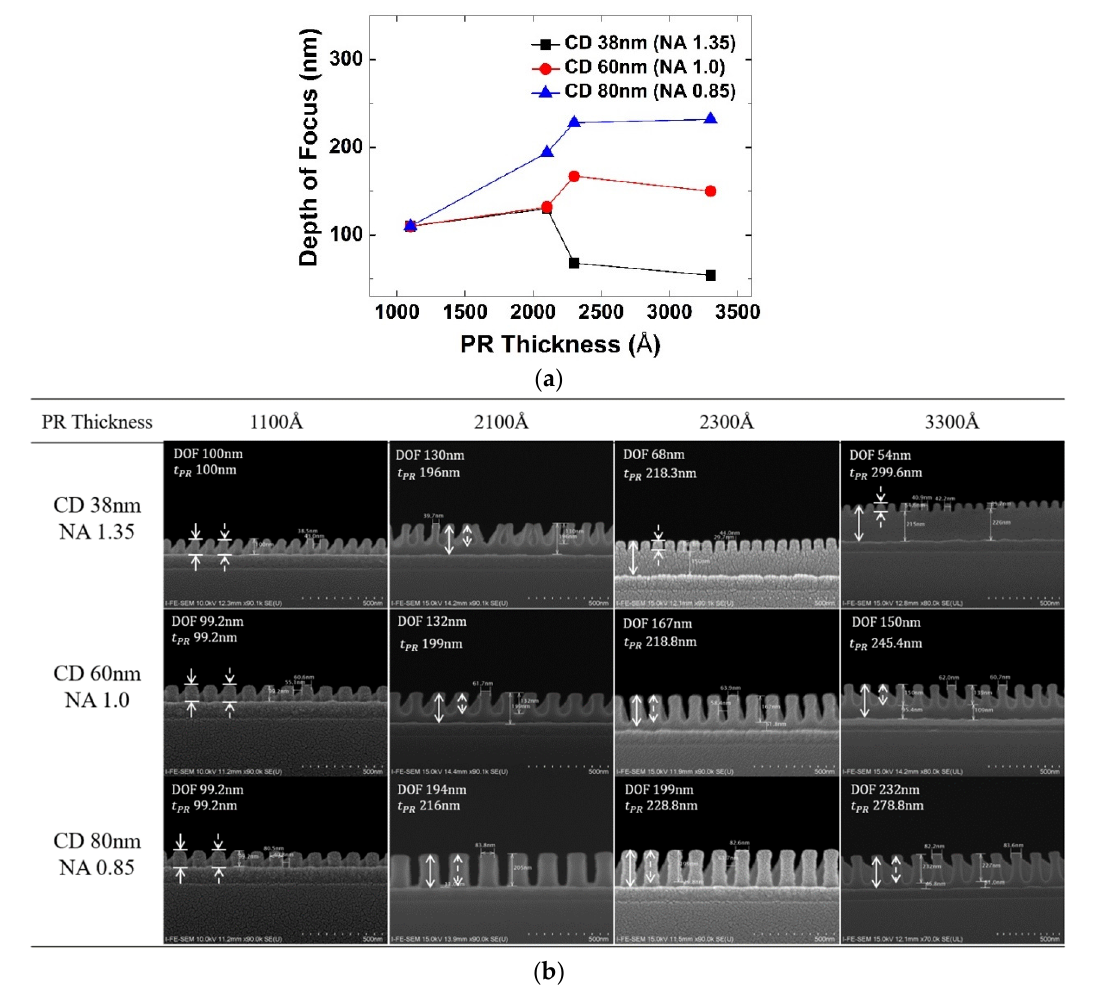
Figure 5. ( a ) Changes in depth of focus according to photoresist thickness, ( b ) result of FE-SEM changes in depth of focus according to photoresist thickness. The dashed arrows indicate the depth of focus and the solid arrows indicate the thickness of PR.